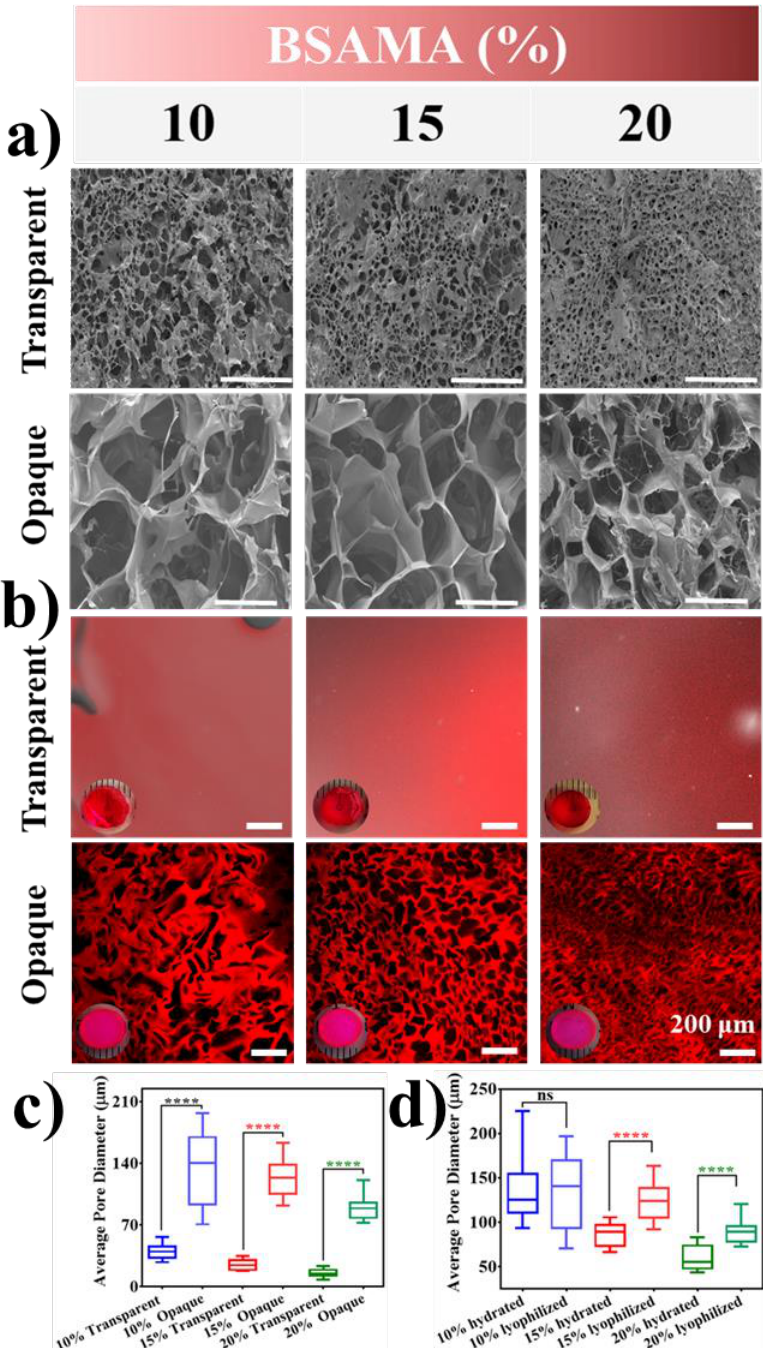
Figure 3. Morphological characterization ( a ) Dried state morphology of as-prepared hydrogels and cryogels using Scanning electron microscopy FF(SEM). ( b ) Hydrated state visualization of the pore structure of Rhodamine B (Rh-B) stained transparent and opaque gels by confocal laser scanning microscopy (CLSM). The red fluorescence dye stains the cryogel wall, and the dark areas are the channels within the matrix. Insets show the optical images of the gels dyed by Rh-B. Scale bar = 200 µm. Optical sections at 30 –40 µm below the gel surface were taken. Images were acquired and processed identically with contrast increased for visibility. Three replicate images of each condition were used to measure the mean pore size by ImageJ for ( c ) opaque and transparent gels by SEM, and ( d ) the hydrated and dried state cryogels by SEM and CLSM, respectively. ****: p < 0.0001; ns = no significant difference.